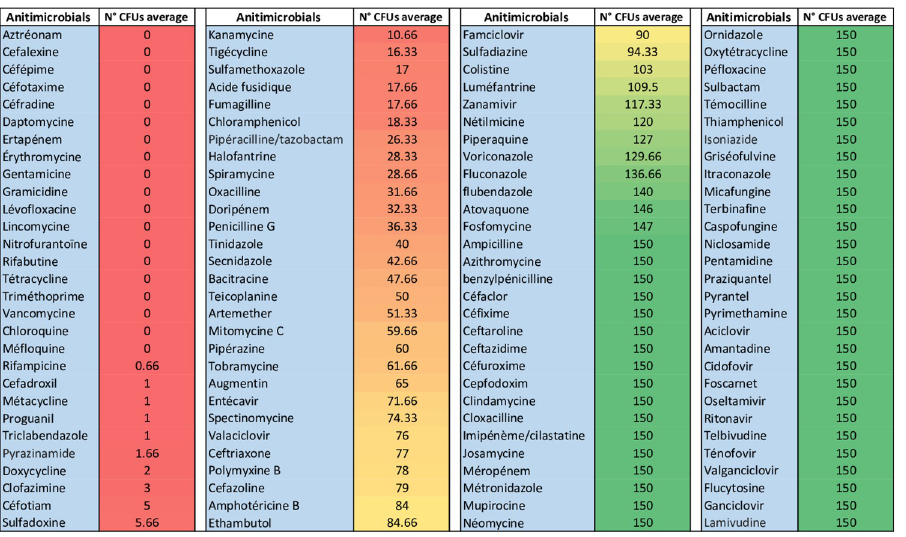
Fig 1. Results of the sensitivity of M . ulcerans against 116 antimicrobials, the color gradient from red to yellow includes antimicrobials that affect the viability of M . ulcerans CU001. The color gradient from yellow to green includes antimicrobials that do not affect the viability of M . ulcerans . (cut of 50% = 75 Avg CFU Nbr].